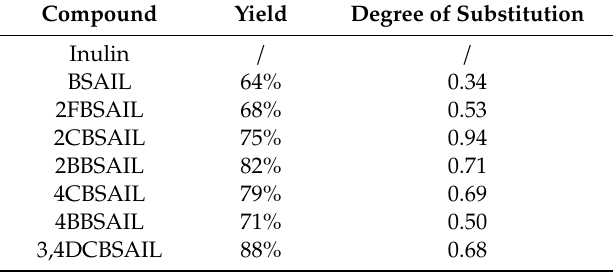
Figure 4. 1 H NMR spectrum of 6-amino-( N -benzylidene)-6-deoxy-3,4-di-O-acetyl inulin (BSAIL) and its integral values of hydrogen protons. Table 1. The yield and the degree of substitution of inulin derivatives.